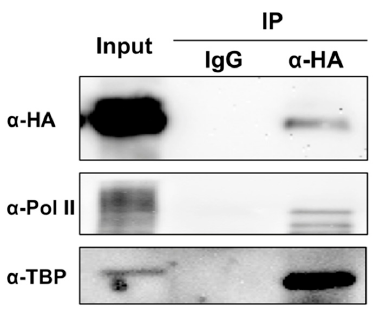
Figure 1. Co-immunoprecipitation of TFIIIA-7ZF/Pol II/TBP. Overexpressed and HA-tagged TFIIIA-7ZF served as a bait and successfully pulled down endogenous Pol II largest subunit and TBP. IgG- and α -HA-conjugated resins were used as negative and positive treatments, respectively. The experimental methods were described previously [21]. IP, immunoprecipated fractions.